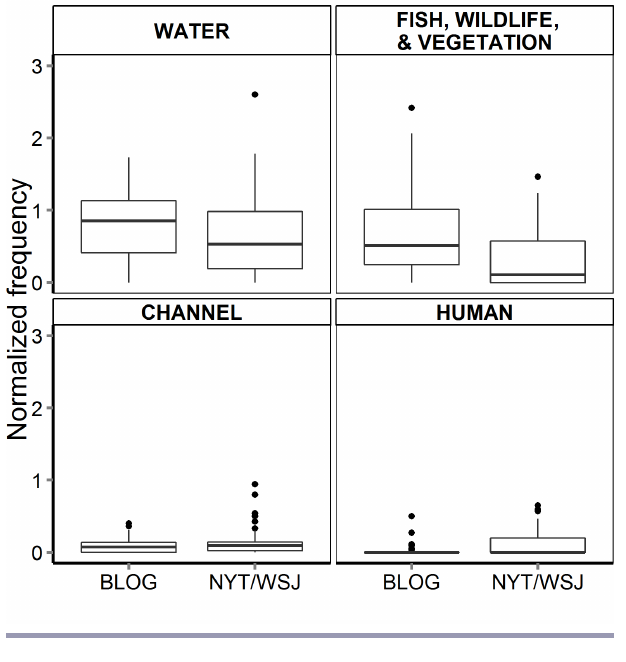
Table 3 . Sequence of multivariate analysis of variance results for attributes.